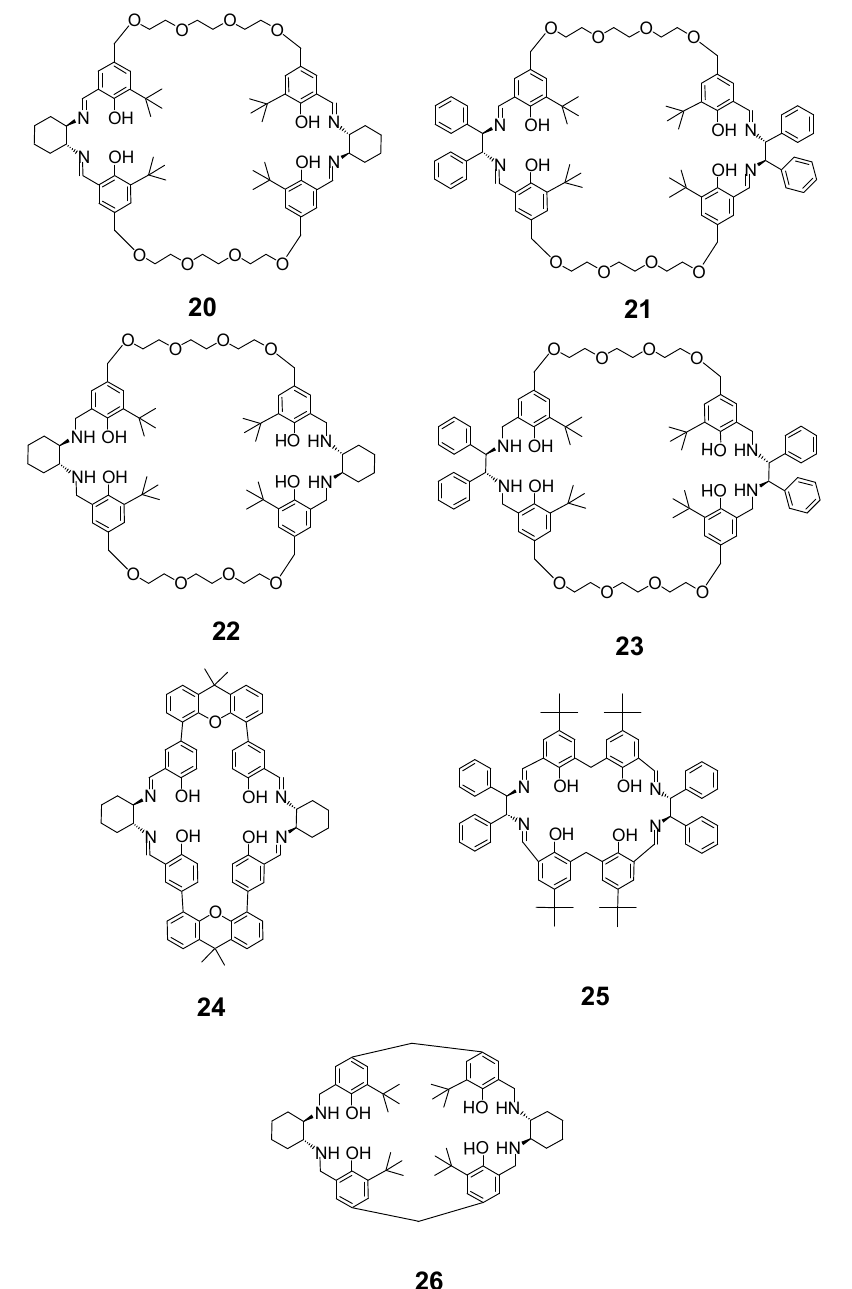
Figure 10. Extended tetraphenolic [2 + 2] macrocycles.